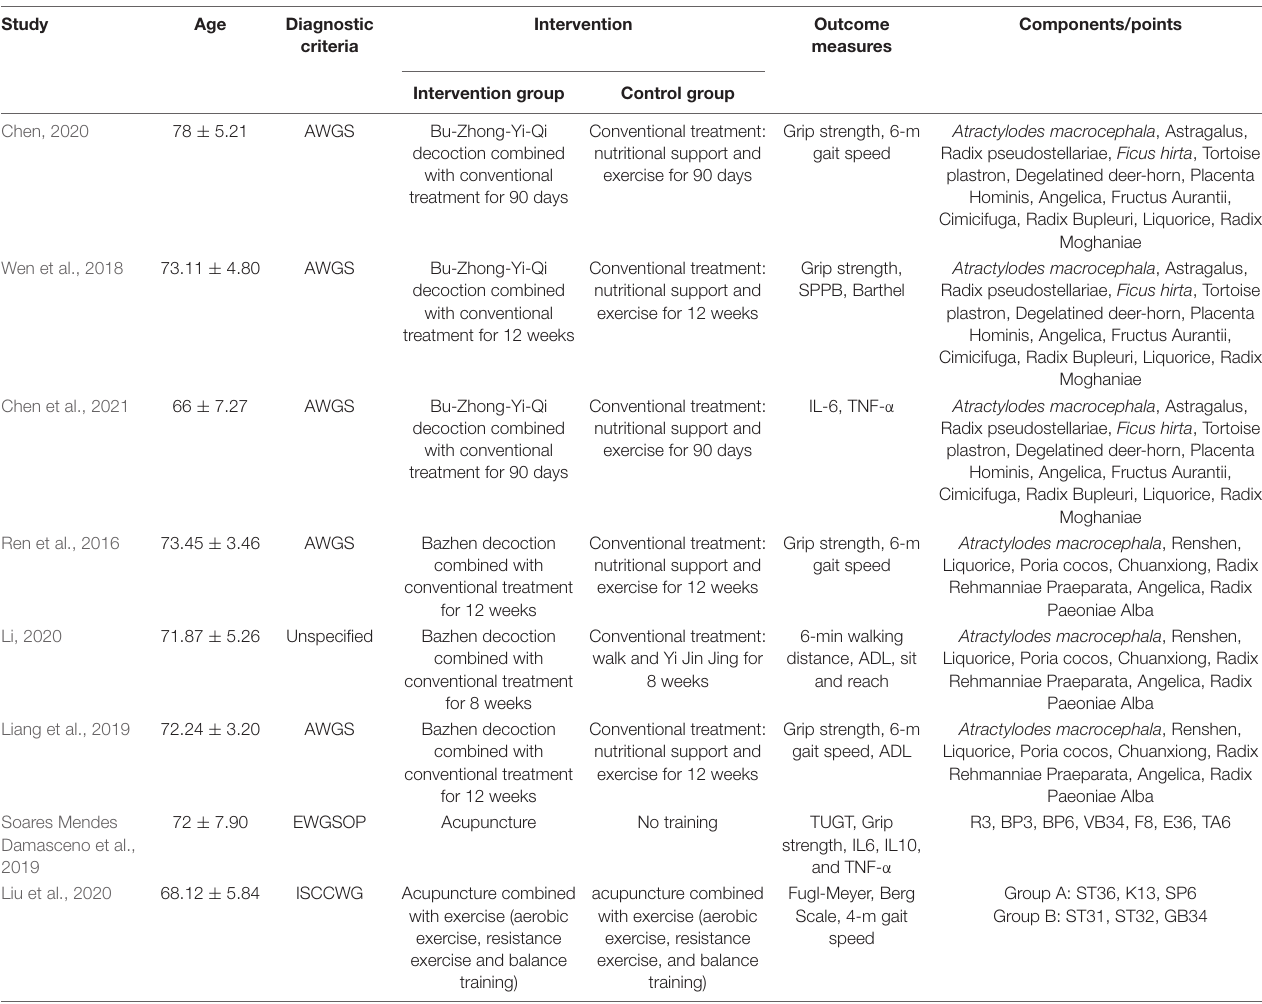
TABLE 2 | Characteristics of the included studies of Chinese herbal medicine and acupuncture. Study